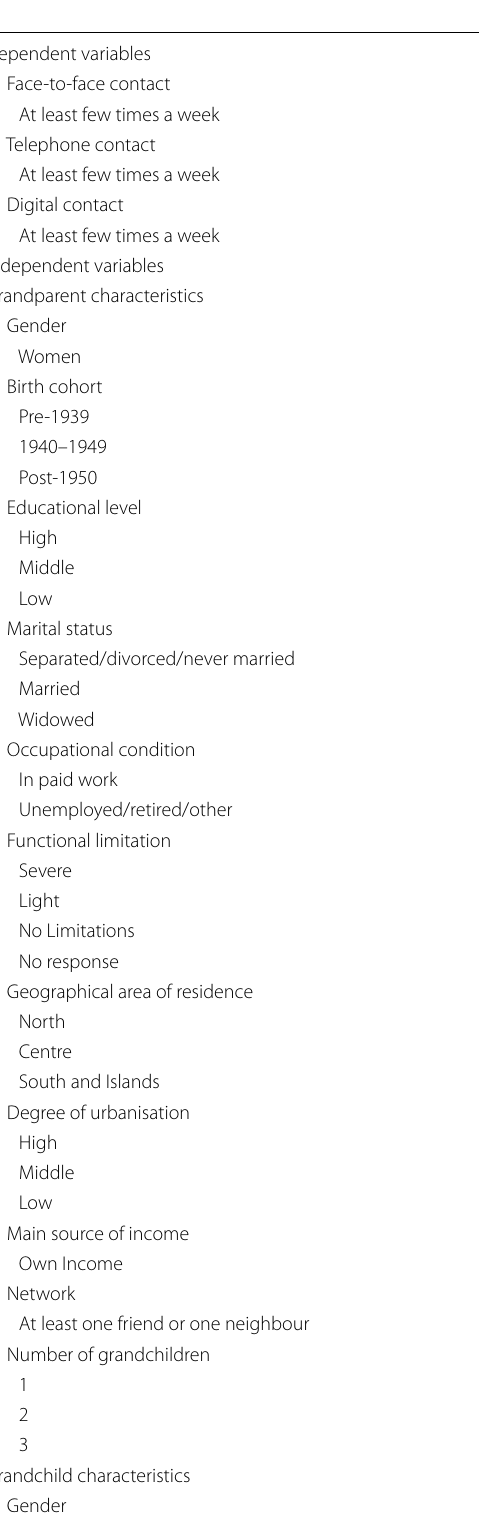
Table 1 Grandparent socio-demographic characteristics: weighted data, total sample Dependent